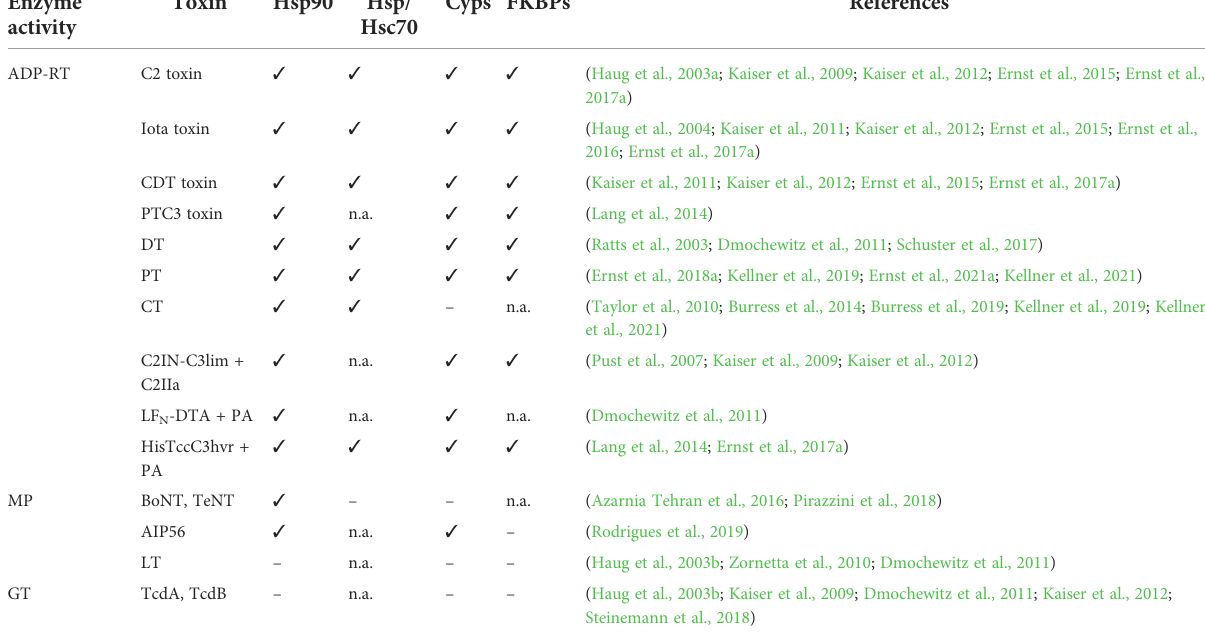
TABLE 1 Overview of requirement of chaperones/PPIases for uptake of bacterial AB-type toxins. Enzyme